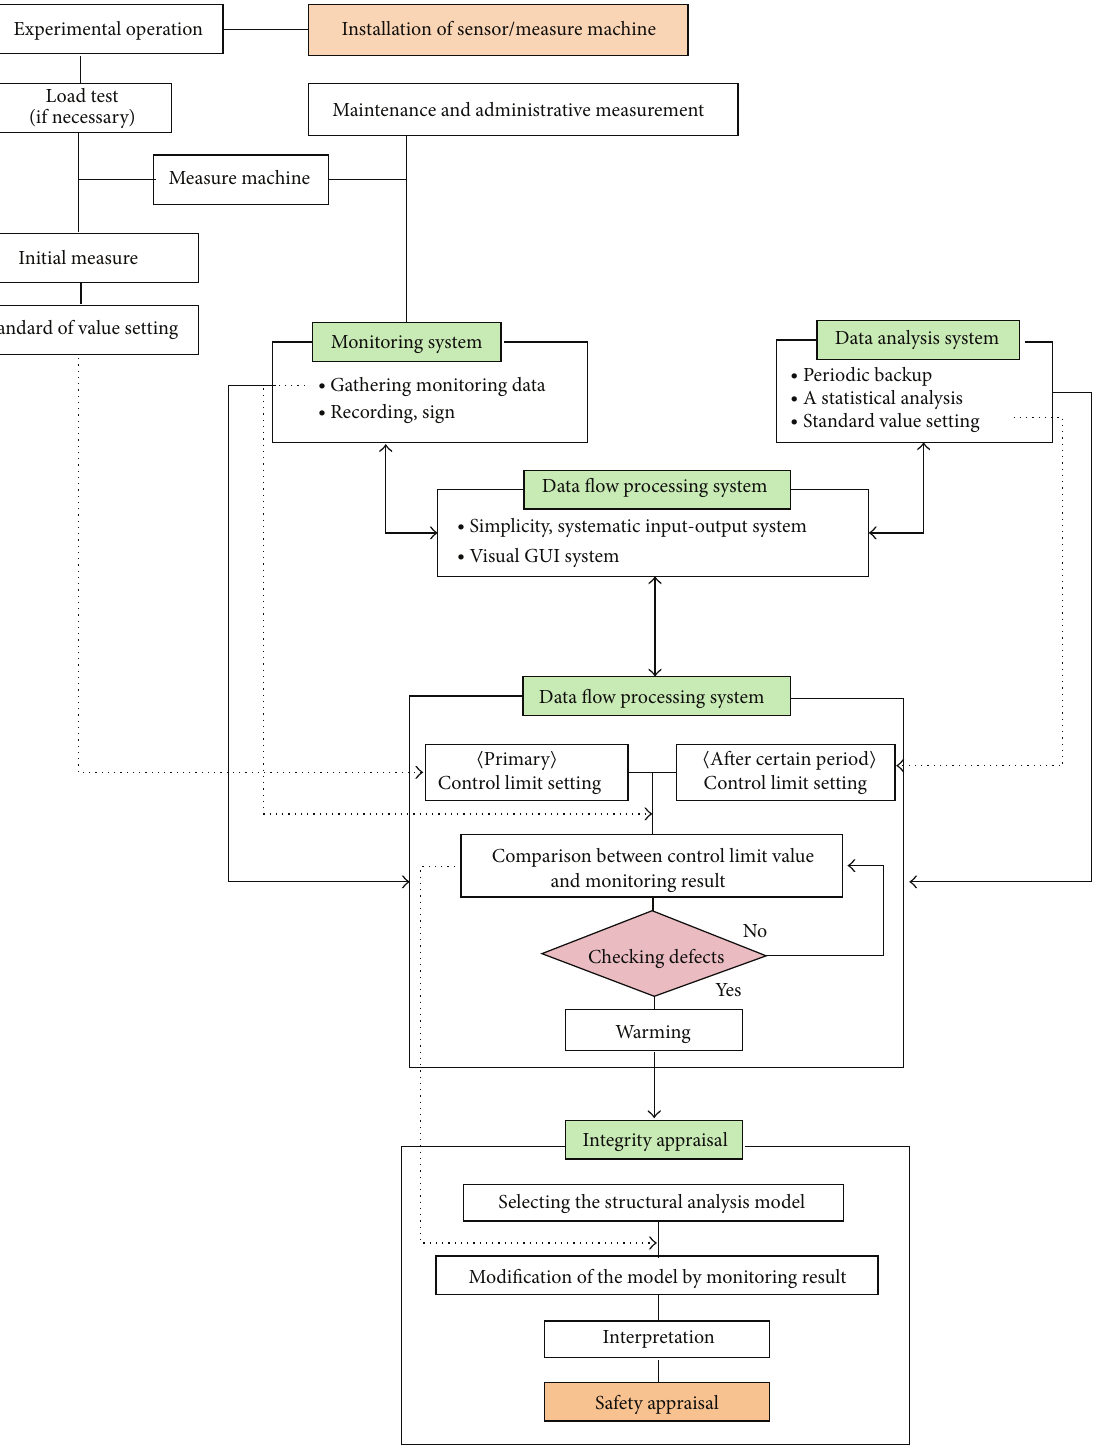
Figure 8: The diagram of monitoring